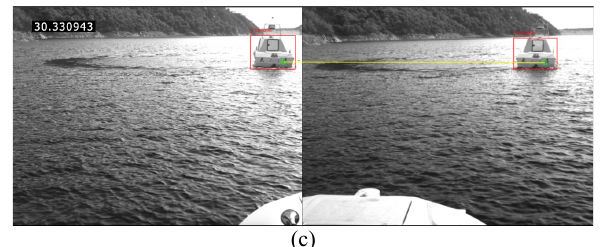
Figure 4. Results of feature extraction, matching and target